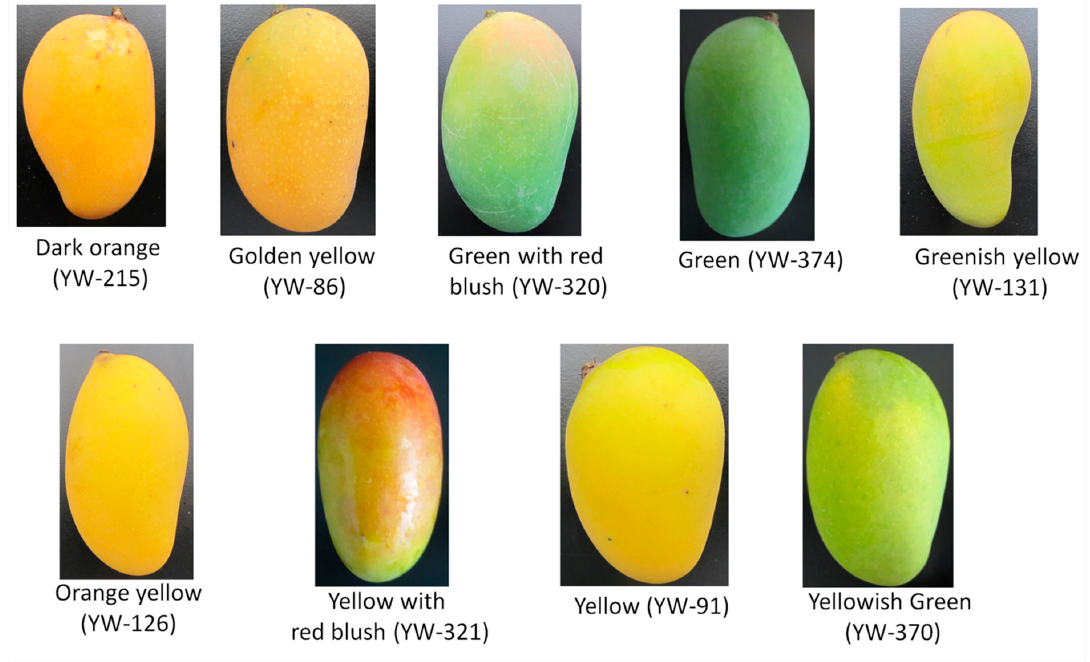
Figure 4. Diversity of color of the fruit pericarp within the mango germplasm. Accession name is in brackets.